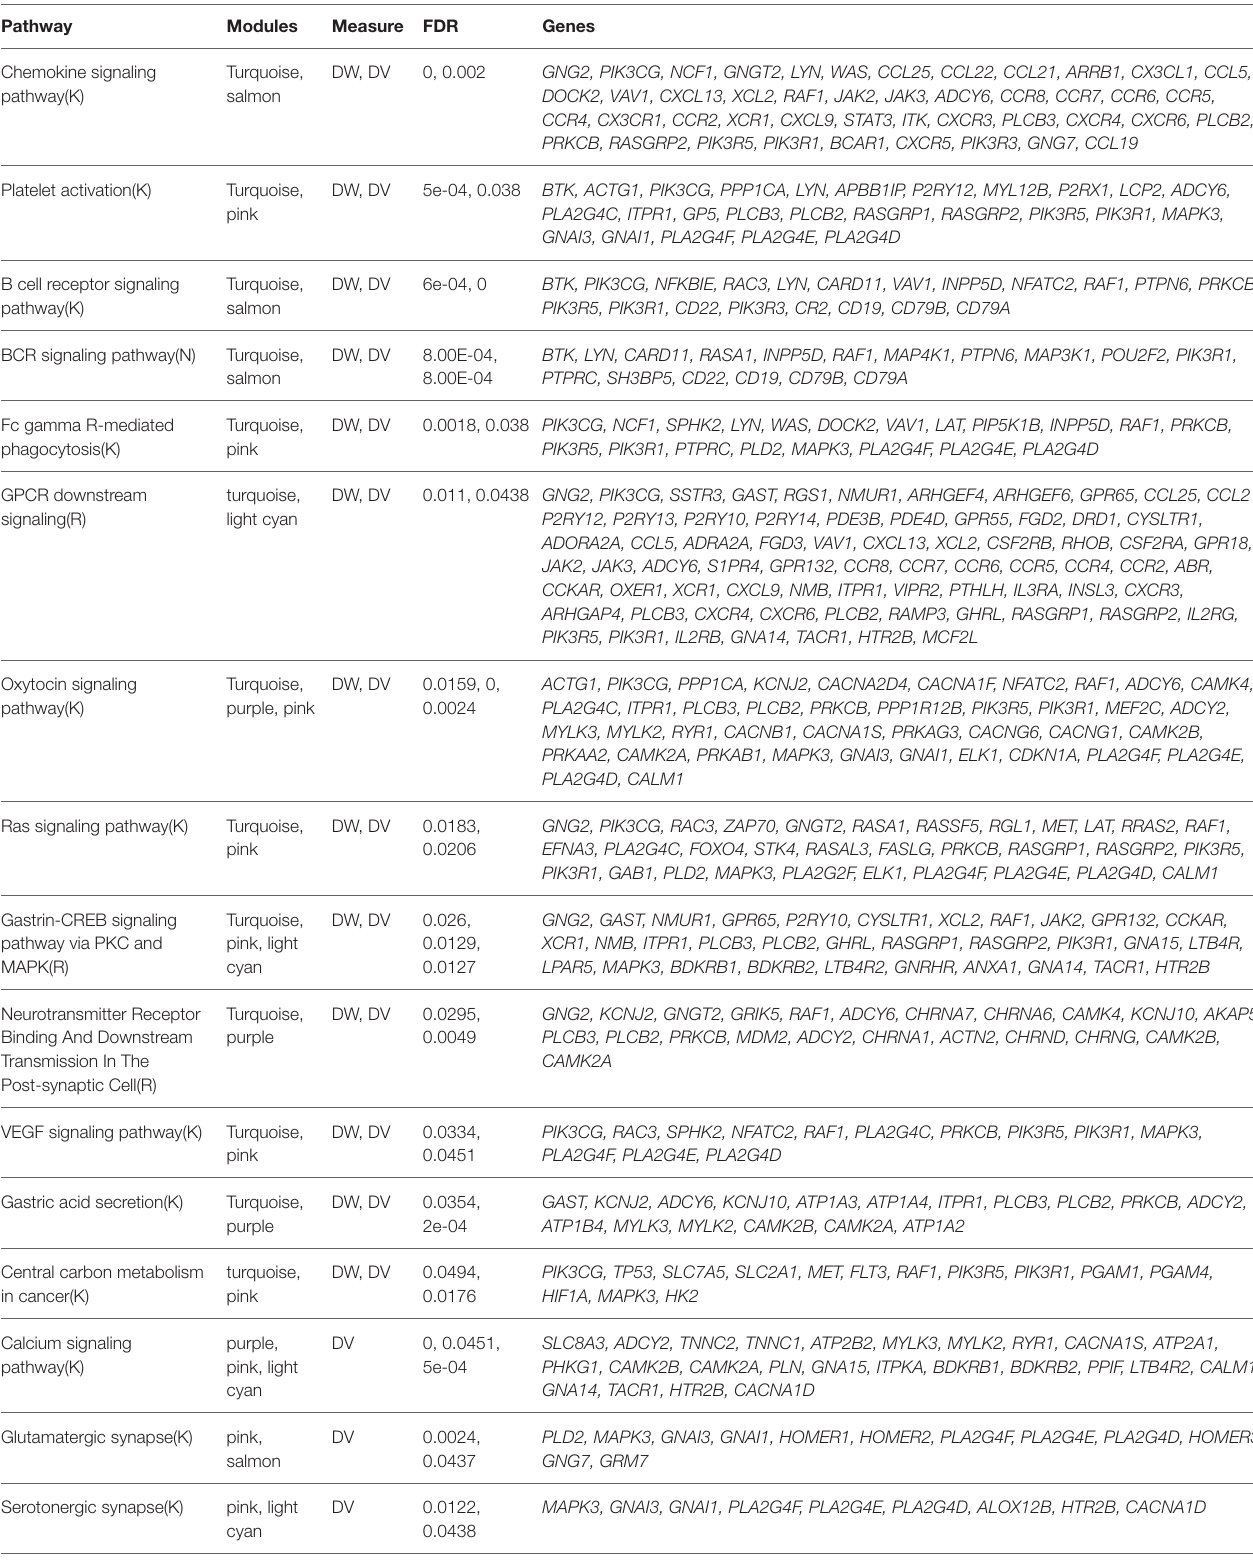
TABLE 3 | Summary of pathway enrichment analysis showing pathways (FDR < 0.05) that overlapped between modules and are enriched in genes showing DV/DW.